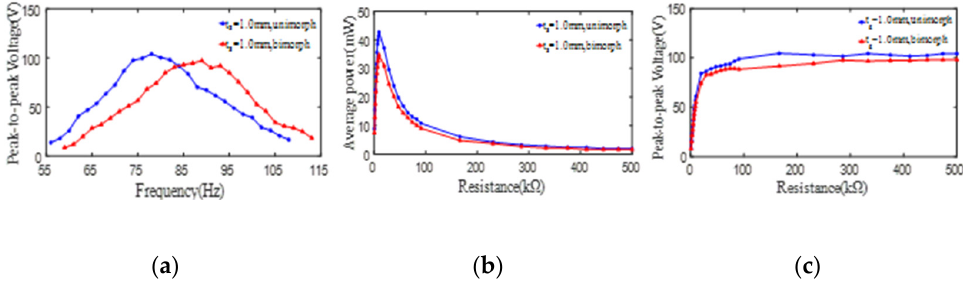
Figure 10. The effect of unimorph PCD and bimorph PCD on the output peak-to-peak voltage and average power of one PZT4 patch ( t s = 1 mm). ( a ) peak-to-peak voltage versus excitation frequency; ( b ) average power versus load resistance; ( c ) peak-to-peak voltage versus load resistance.